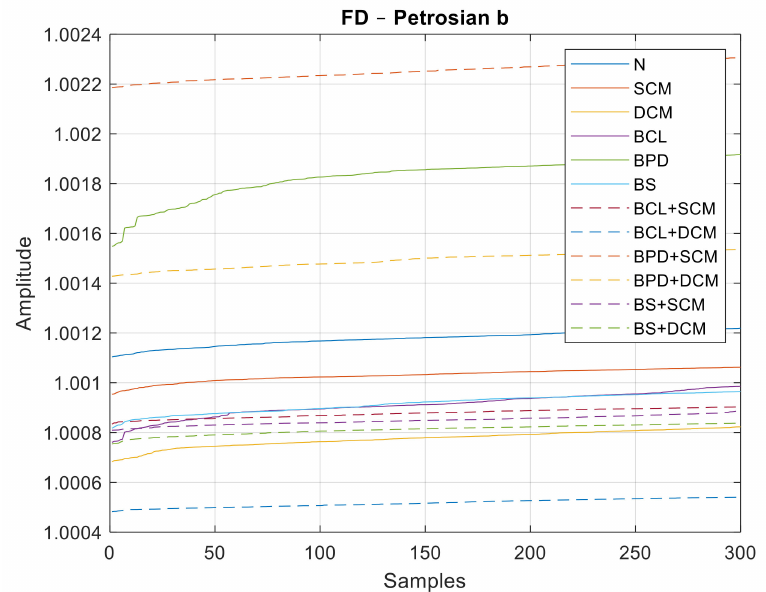
Figure 28. FD values for the Petrosian b method.